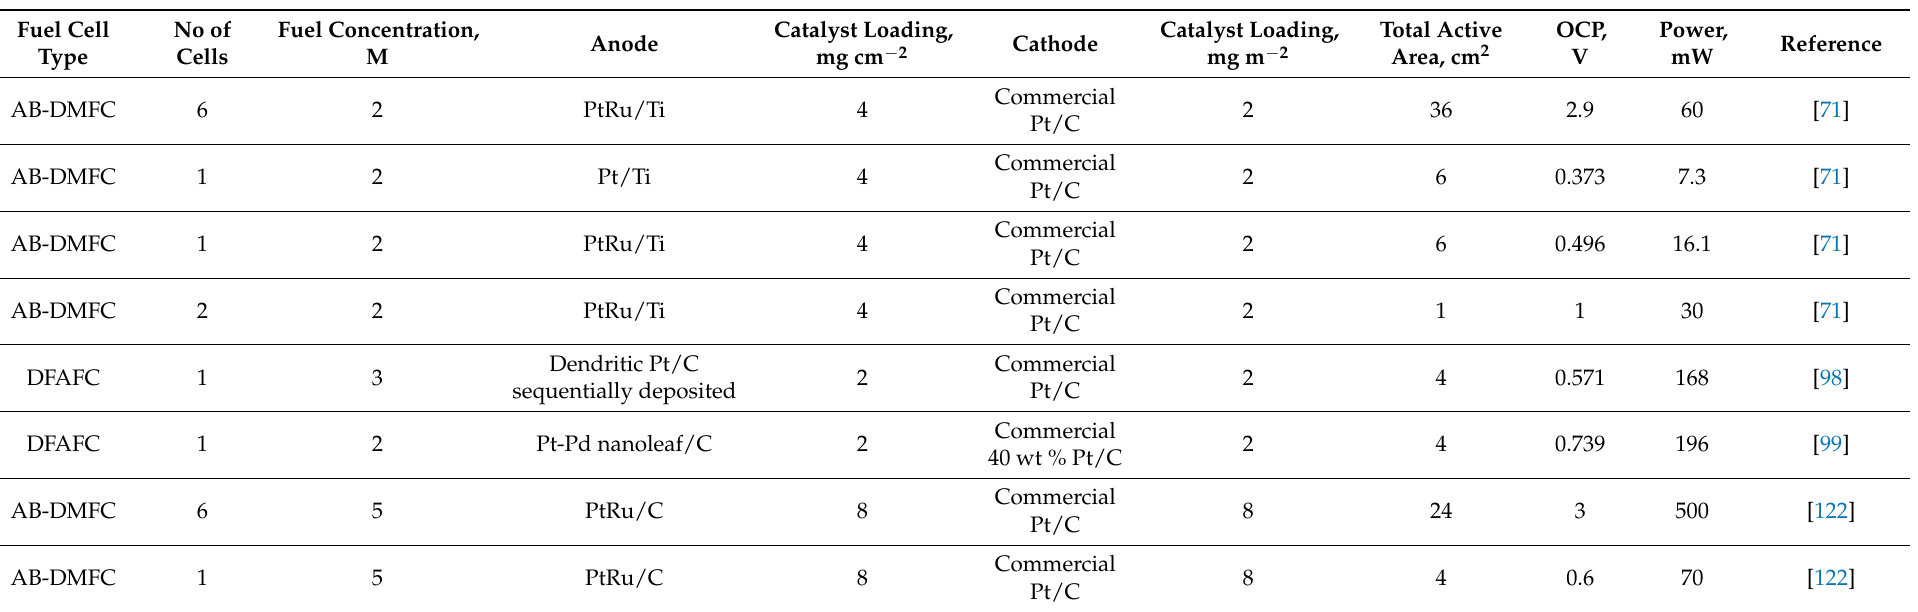
Table 6. Summary of the fuel cell tests conducted utilizing the electrodeposited catalysts with different liquid fuels: methanol and formic